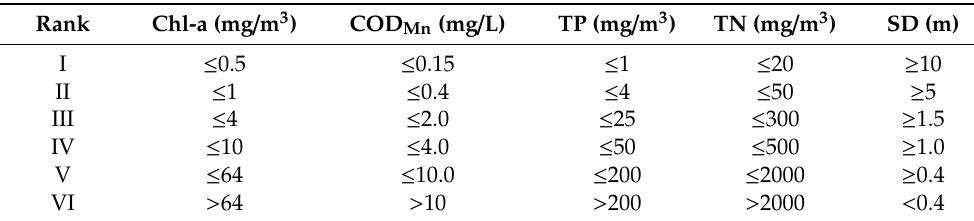
Table 2. Criteria of grading index for eutrophication of lake.